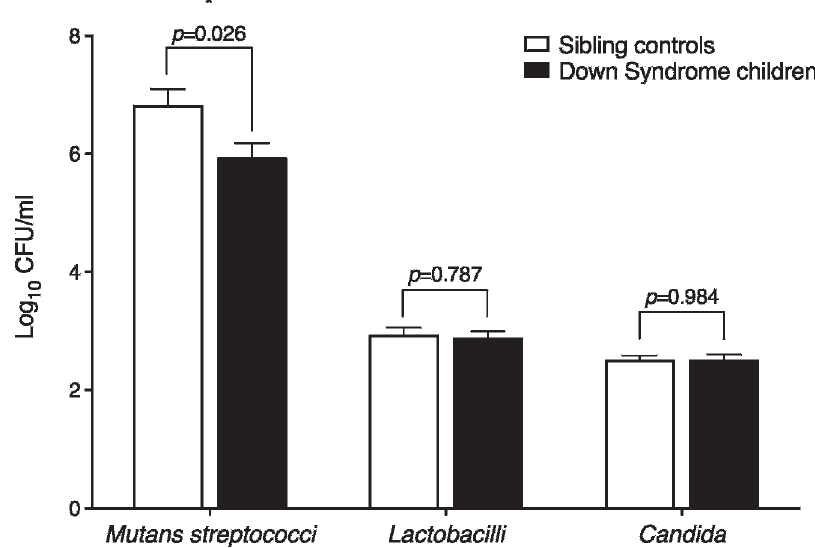
Figure 2 - Mutans streptococci, lactobacilli and Candida salivary levels in Down syndrome children and sibling controls. The bars represent the means, and error bars represent the SD. p -values were calculated using the Student’s t-test. *Values are significantly different between DS and sibling controls.